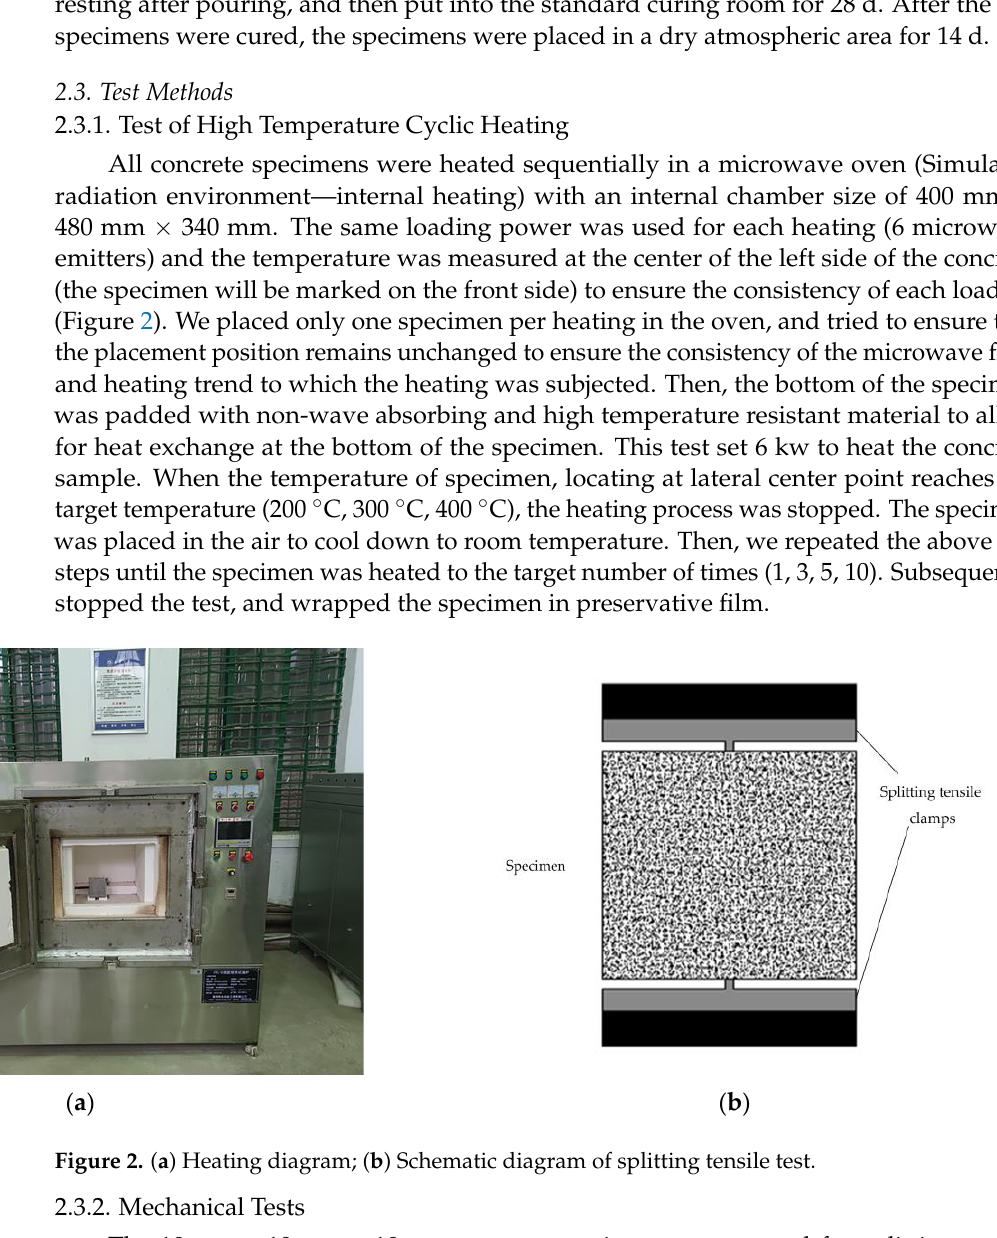
Table 3. Mix ratio of magnetite concrete.